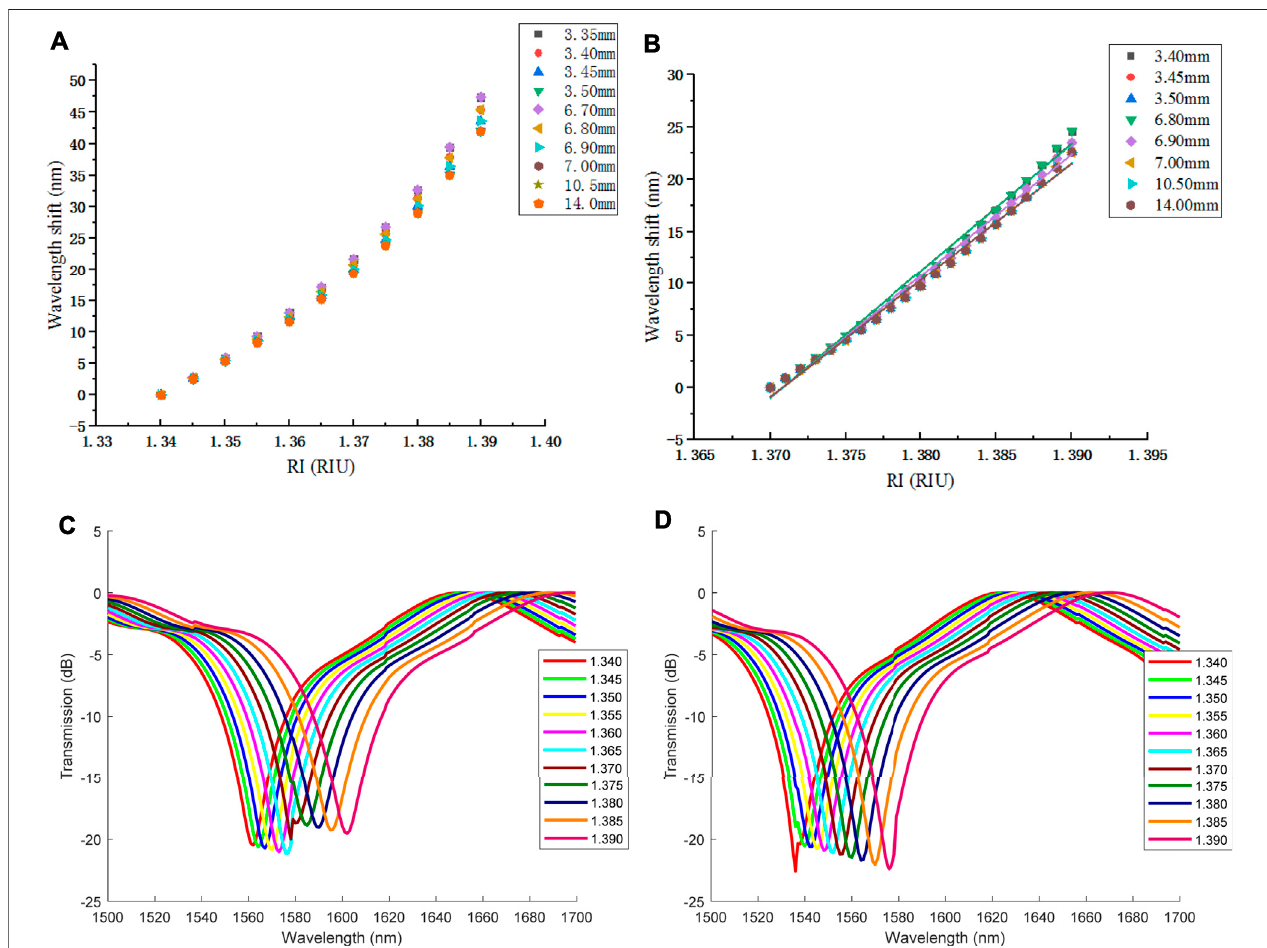
FIGURE 6 | RI sensitivity of self-imaging length variation when D1 (cid:2) 30 μ m: (A) wavelength shift; (B) linear fi tting; (C) transmission spectrum of 6.70 mm; (D) transmission spectrum of 6.80 mm.